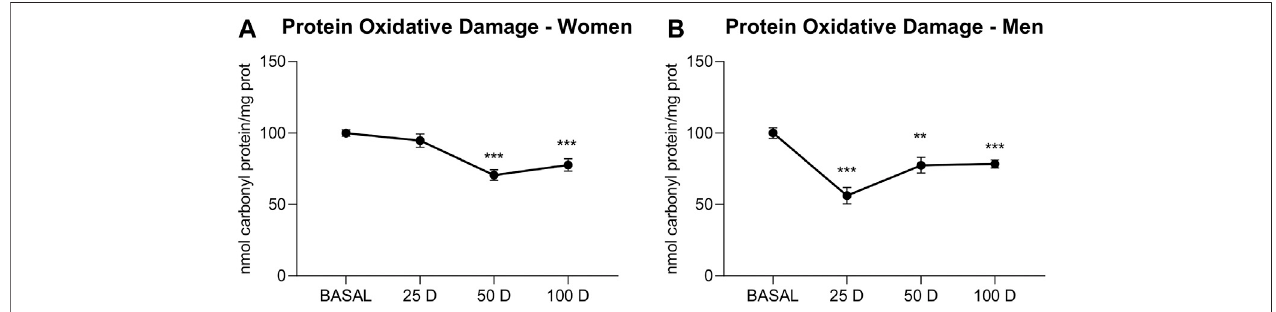
FIGURE 2 | Protein oxidative damage (expressed as nmol carbonyl protein/mg prot) of plasma extracted from women (A) and men (B) at baseline (BASAL), 25 days (25 D), 50 days (50 D) and 100 days (100 D). Data are mean ± SEM. *BASAL vs. 25, 50 and 100 D. The number of symbols marks the level ofsigni fi cance: one for p <